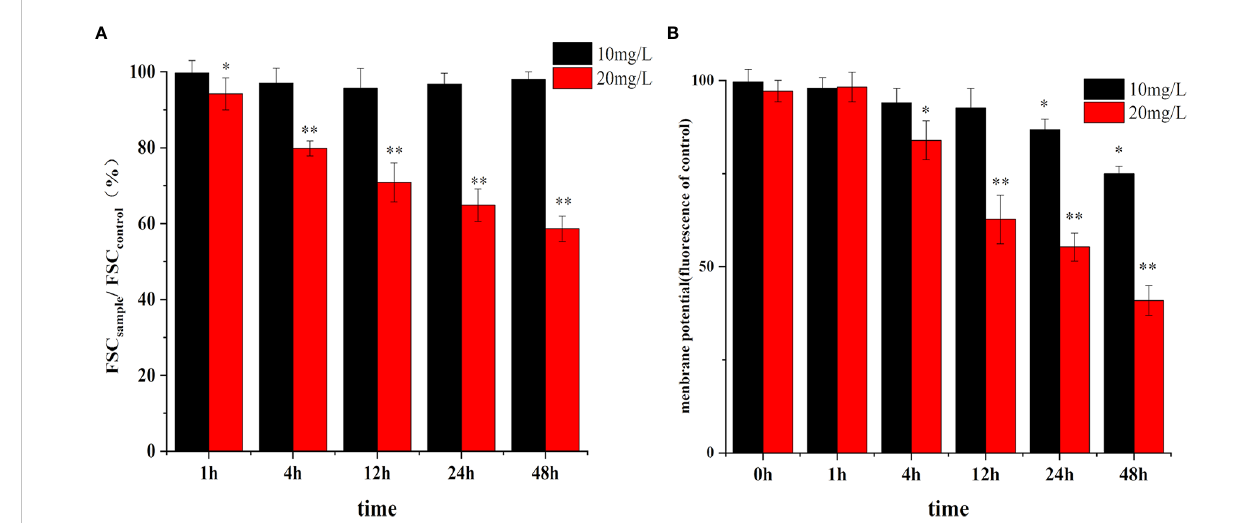
FIGURE 8 Effect of algicidal substance treatment on cell size (A) and membrane potential (B) . (* represents p<0.1, ** represents p<0.05).